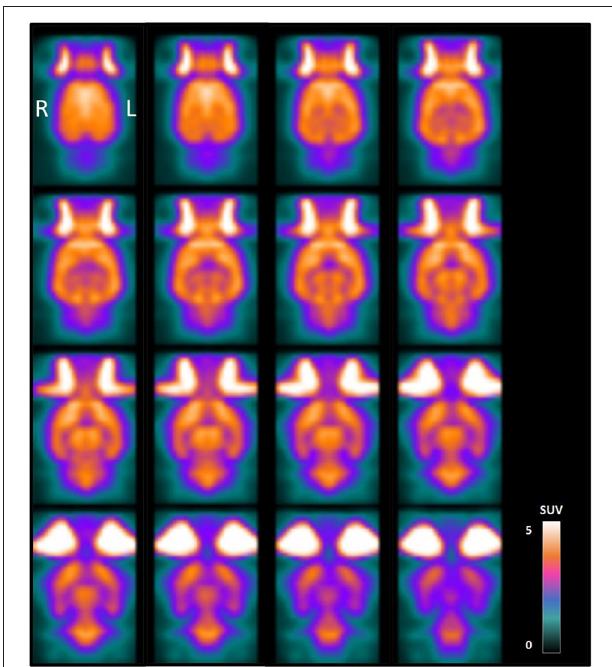
FIGURE 3 | Between-subject coefficient of variation obtained by voxel-wise calculating the ratio of the standard deviation to the mean of the [18F]-FDG images from the 28 healthy adult male Sprague-Dawley rats used to generate the normal brain template. Coronal slices are shown from dorsal (top left) to ventral (bottom